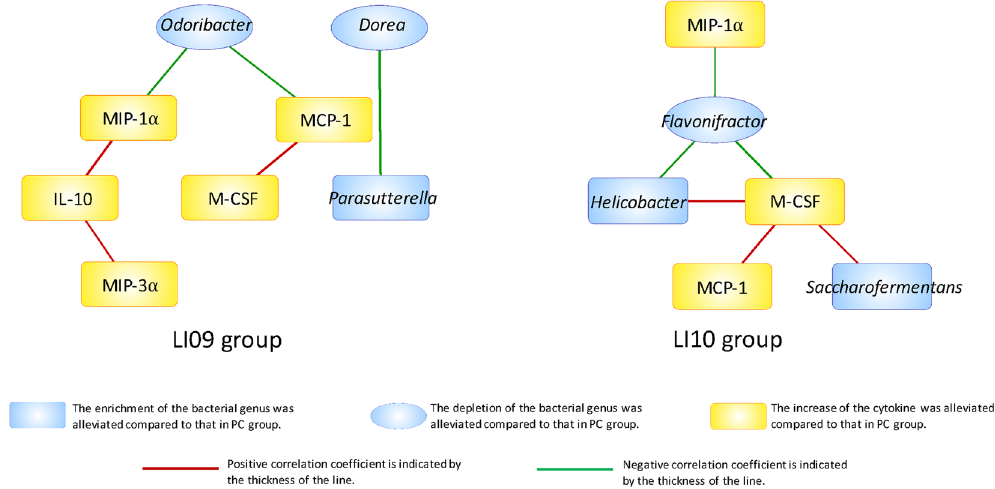
Figure 6. Correlation-network analysis of plasma cytokines and gut bacterial genera of D-GalN-sensitized rats who received B. pseudocatenulatum LI09 or B. catenulatum LI10. A Spearman correlation analysis was performed, and only correlations with p < 0.05 are displayed. Blue nodes represent bacterial genera, and yellow nodes represent cytokines. The ellipses indicate that the depletion of the bacterial genera was alleviated compared to that in the PC group, and the round rectangles indicate that the enrichment of the bacterial genera was alleviated or the increase of the cytokines was alleviated compared to that in the PC group. A red line connecting nodes represents positive correlation, and a green line represents negative correlation. Values of the corresponding correlation coefficients are indicated by the thickness of the line; the thicker the line, the greater the